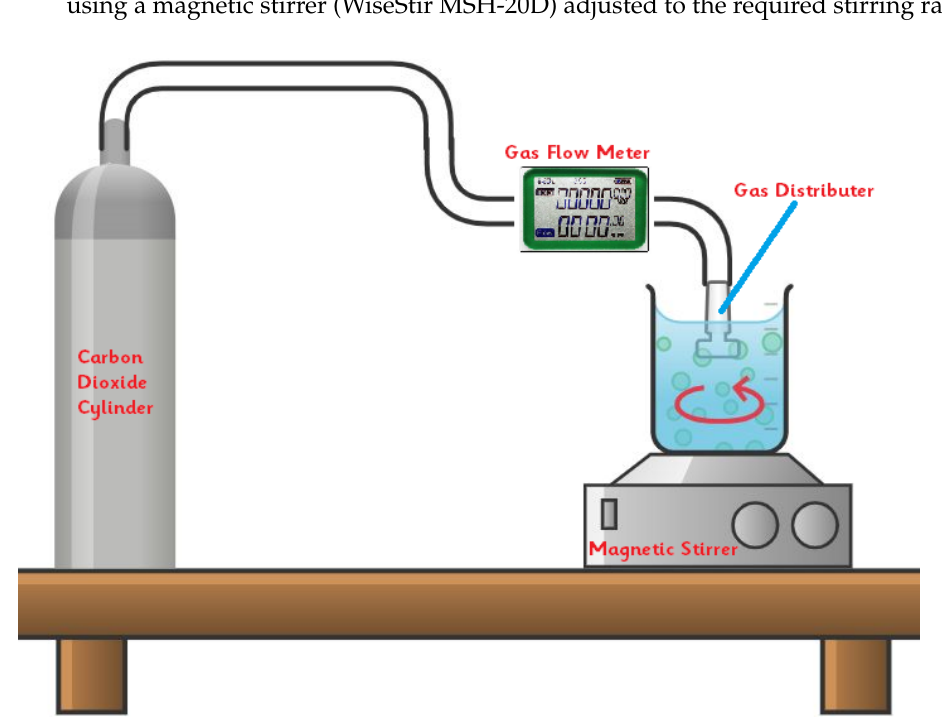
Figure 2. Experimental setup for CaCO 3 production.